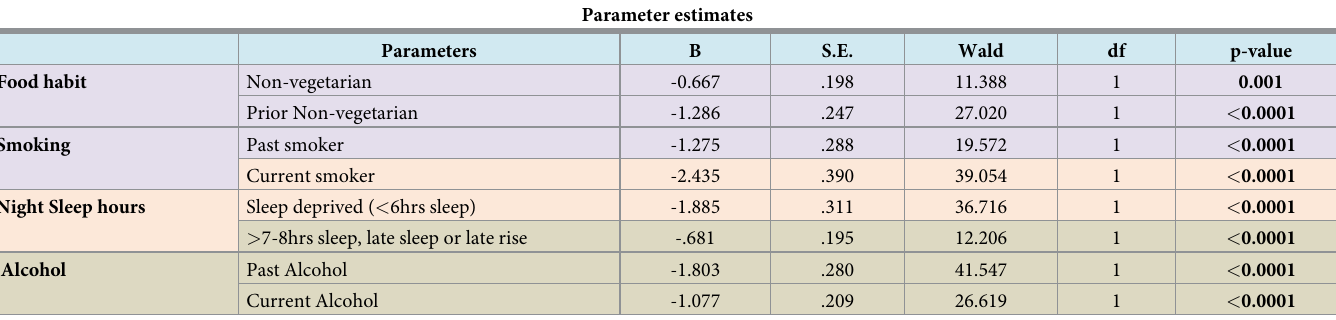
Table 6. Multinomial logistic regression to examine the contribution of ADL in AMD severity.